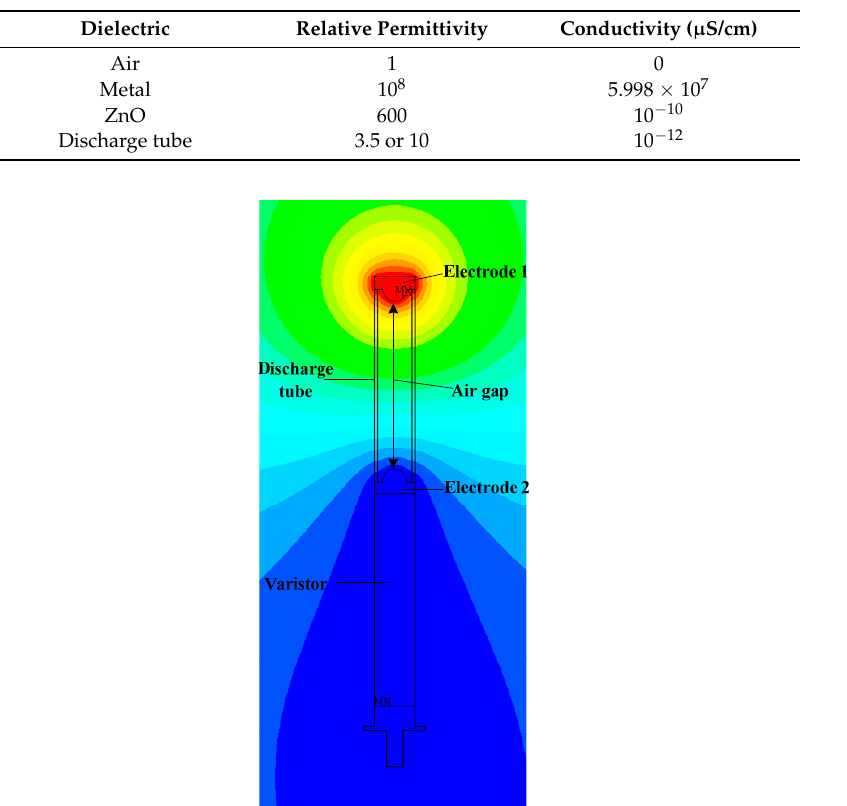
Figure 6. The electric field simulation of the internal gap structure. MX is the maximum potential, where the voltage is applied. MN is the minimum potential, where is contact with the earth.